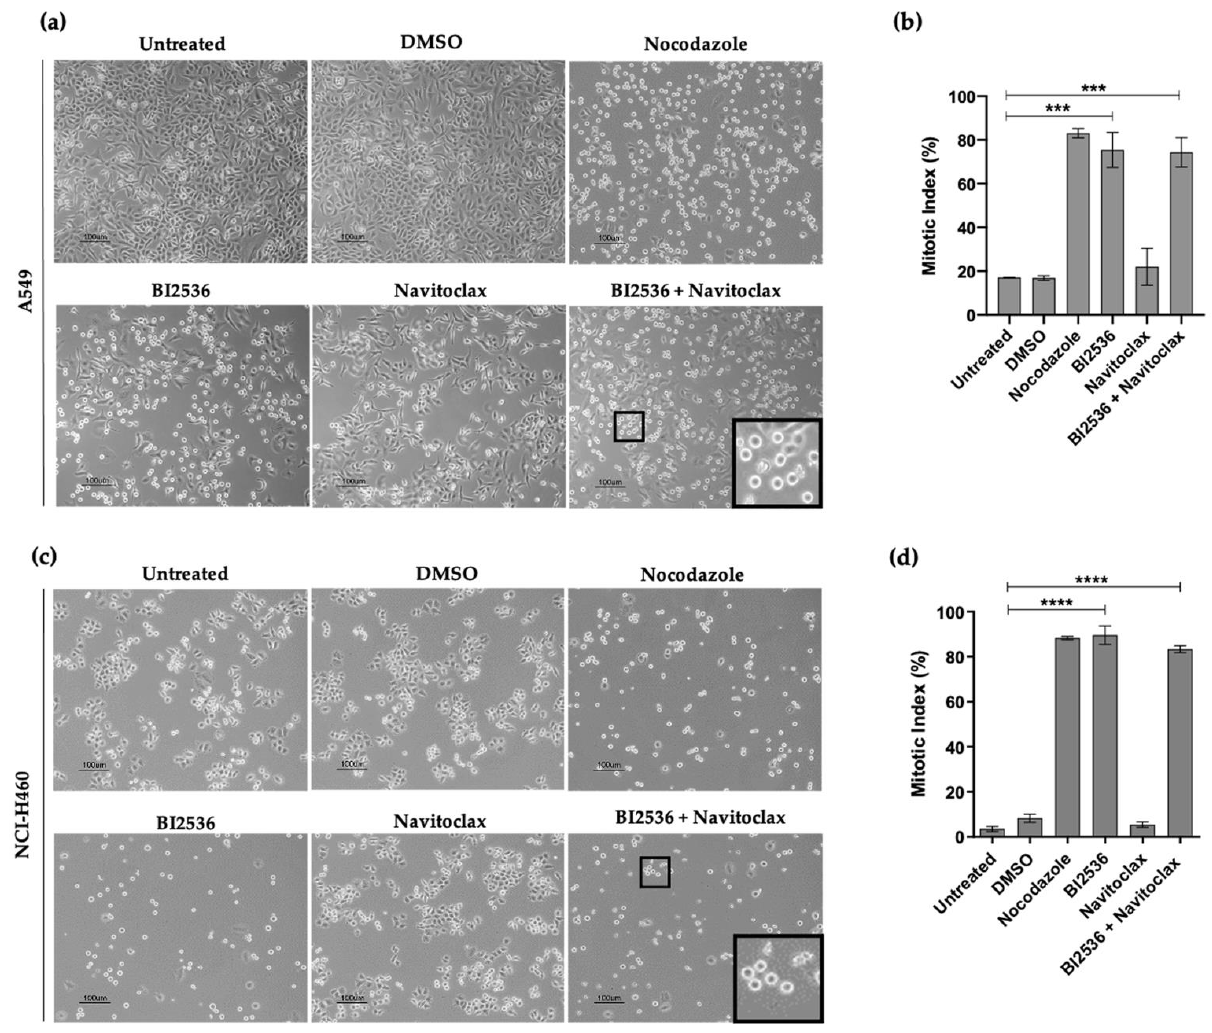
Figure 3. BI2536, but not Navitoclax, induces mitotic arrest of lung cancer cells. Representative phase-contrast microscopy images of untreated BI2536 (125 nM in A549 and 62.5 nM in NCI-H460), and Navitoclax (62.5 nM in A549 and 125 nM in NCI-H460) co-treated cells, for 24 h, showing accu- mulation of rounded and bright cells (mitotic cells) in A549 ( a ) and NCI-H460 ( c ) cell lines. Cells treated with up to 0.25% DMSO (compound solvent) and 1μM Nocodazole (antimitotic ag ent) were used as controls. Mitotic index graph showing accumulation of A549 ( b ) and NCI-H460 ( d ) mitotic cells with statistical relevance of *** p < 0.001 and **** p < 0.0001 by one-way ANOVA with Tukey ’ s multiple comparisons test from three independent experiments. Bar, 100 µm. Data were expressed as mean ± SD. Antimitotic agents induce prolonged mitotic arrest through activation of the SAC [31]. Then, treated cells either die in mitotic arrest or slip out of mitosis, without cell divi- sion, into an abnormal G1 state in which they may die, arrest in a tetraploid G1 state, or continue to proliferate [19]. Slippage is a major mechanism contributing to drug resistance [20]. Therefore, an ideal strategy should shift the fate of antimitotic-treated cells to death instead of slippage. To this end, we analyzed the cell fates after treatment with the BI2536/Navitoclax combination, taking advantage of time-lapse microscopy, which allows monitoring the spatiotemporal dynamics of live cells (Figure 4a).